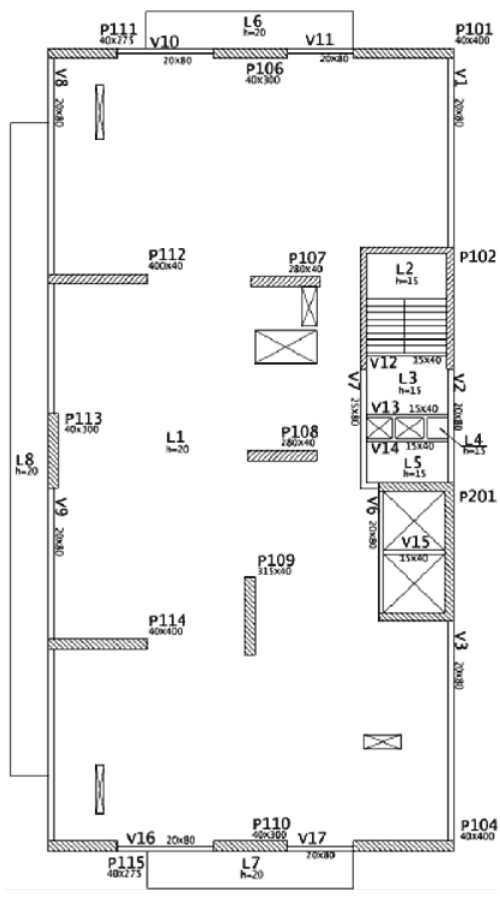
Figura 6 Planta baixa do pavimento tipo do modelo final da